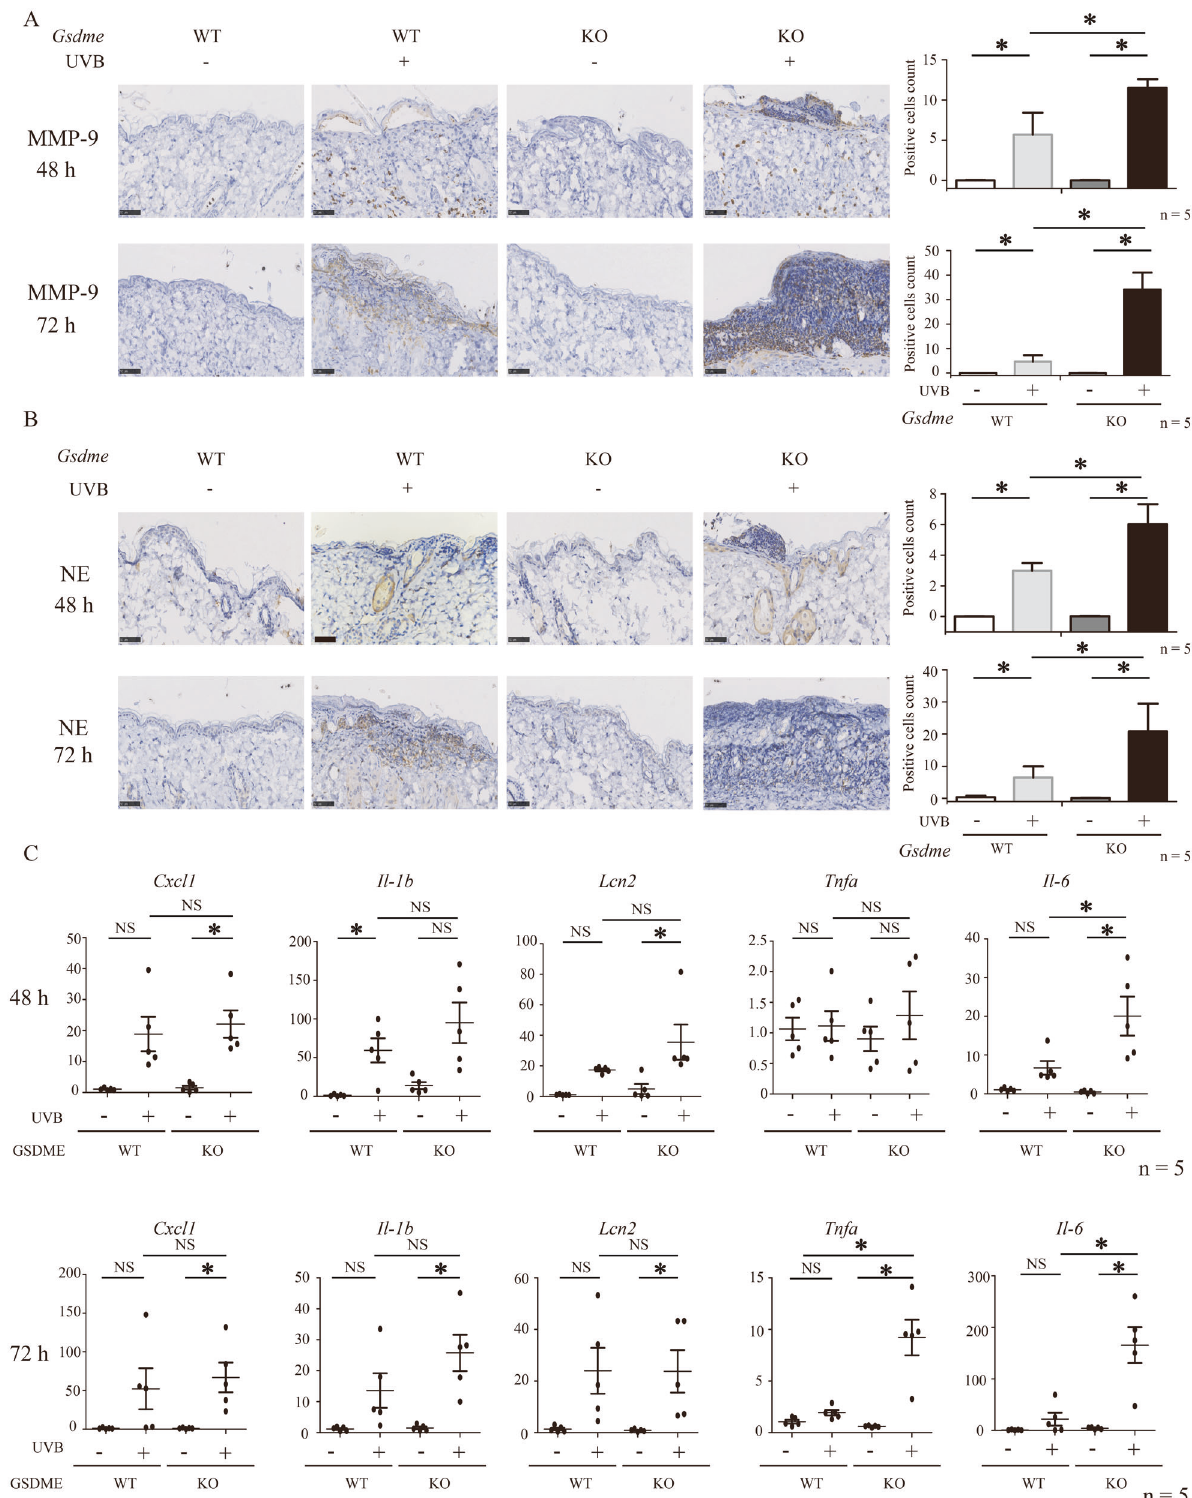
Fig. 4 Neutrophils activation indicators MMP-9 and neutrophil elastase are increased in UVB-challenged Gsdme − / − mice. A , B The protein levels of MMP-9 ( A ) and neutrophil elastase (NE) ( B ) were detected in skin tissue at 48 and 72 h after UVB exposure by immunohistochemistry assay ( n = 5). Scale bar represents 50 μ m. C The mRNA levels of Cxcl1, Il1b, Lcn2, Tnf α , and Il6 in whole skin lysate at 48 and 72 h after UVB exposure. GAPDH served as the reference gene. n = 5. * P < 0.05. NS nonsense.